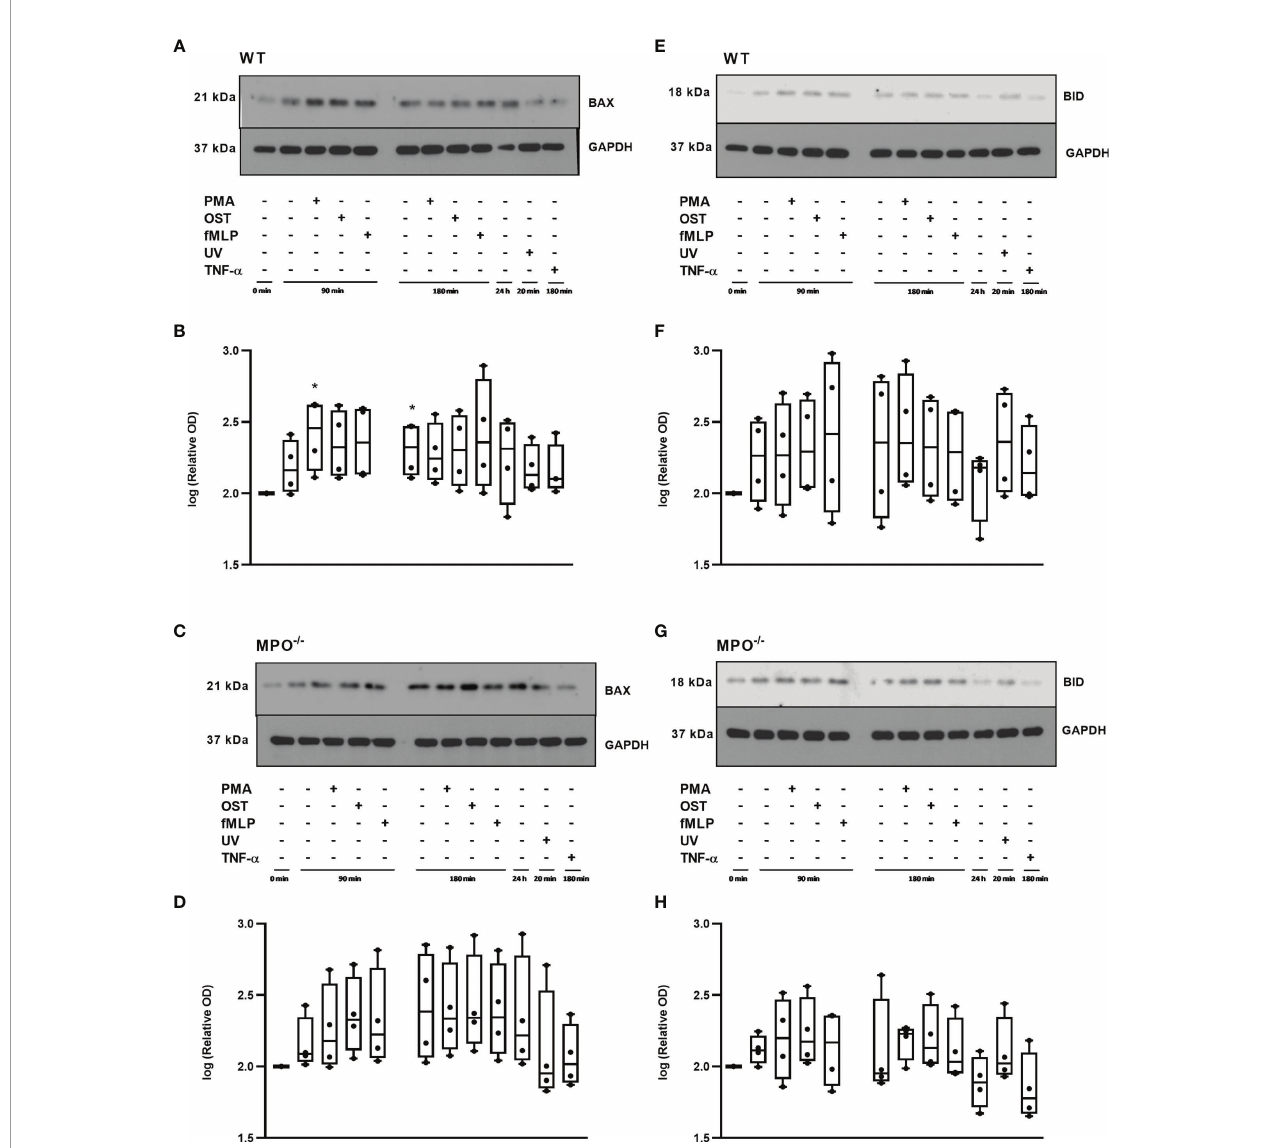
FIGURE 4 | Apoptotic proteins Bax (A-D) and Bid (E-H) in PMNs isolated from in fl amed lungs of WT (A, B, E, F) and MPO -/- (C, D, G, H) mice after induction of oxidative burst by PMA, OST, and fMLP for 90 min and 180 min. PMNs (1x 10 7 cells/ml) isolated from BALF of WT and MPO -/- mice were stimulated with PMA (80 nM), OST (1:10 MOI) and fMLP (1.14 m M) for 90 and 180 min. PMNs incubated for 24 h without stimulation, PMNs irradiated by UV for 20 min, and PMNs treated by TNF- a (10 ng/ml) for 180 min were tested as positive controls. Proteins Bax, Bid and GAPDH (as a marker of equal loading) were determined by Western blot. Analysis of OD was performed using ImageJ, and values are depicted as percentage of untreated control transformed by Log2 to normalize the data distributions (B, D, F, H) . Data are presented as median, 25, and 75 percentiles (the box) and 10 and 90 percentiles (the whiskers), and individual values are drawn as individual dots, n = 4. *Shows statistically signi fi cant difference (p < 0.05) compared with untreated control (Ctrl). Figures (A, C, E, G) represent typical